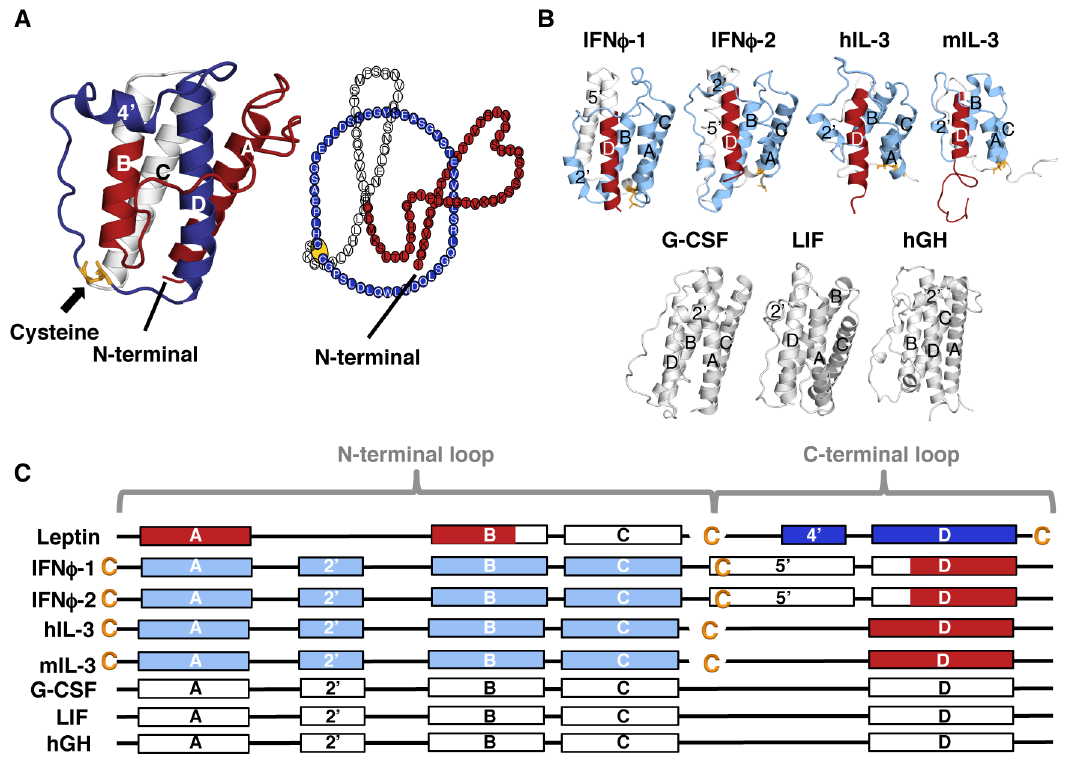
Figure 2. The unique topology of a Pierced Lasso Bundles (PLBs). (A) The native structure of leptin (PDB code 1AX8 [79]). A disulphide bridge is located between residue C96 and the C-terminal cysteine (yellow), creating a covalent C-terminal loop (dark blue). Consequently, a helical hairpin of helix C and half of helix B (white), have to thread through the covalent loop to reach the native state. The N-terminal part stays in front of the covalent loop (red). Hence, the overall conformation of the protein creates a Pierced Lasso Bundle (PLB) topology [12]. ( B ) Four of the new PLBs that we discovered in the PDB plus three unthreaded four-helix bundles are shown in ribbon diagram format. These new PLB proteins have their covalent loop at the opposite end from leptin, creating an N-terminal lasso (light blue). The threaded element (white) is behind the loop from this view while the C-terminal end (red) is in front of the covalent loop. ( C ) A cartoon defining the elements of the different PLBs showing the PL in blue (dark blue for a C-terminal lasso and light blue for an N-terminal lasso). The threaded element, behind the covalent loop, is white and the terminal in front of the loop is red. The unthreaded foud-helix bundles are shown in white.